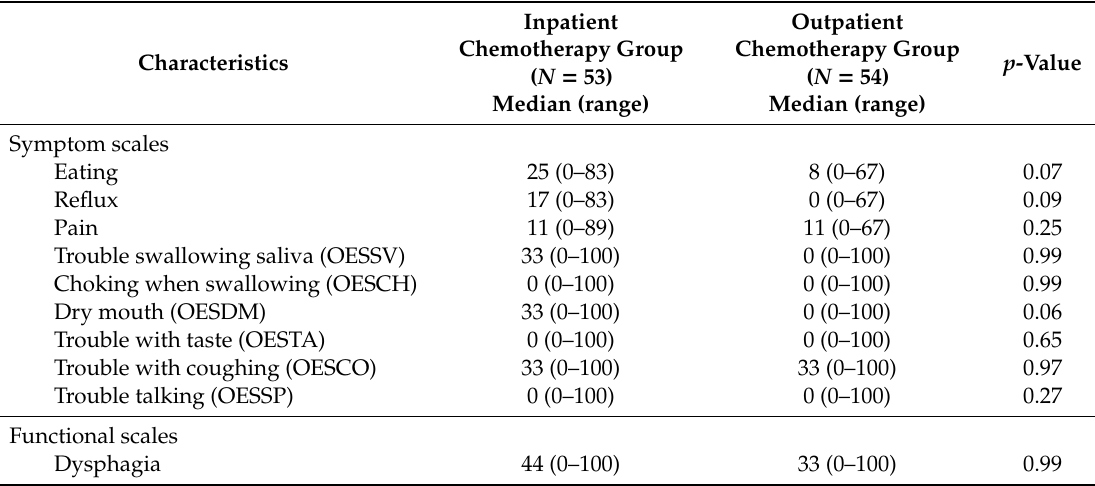
Table 3. EORTC-QLQ-OES18 symptom